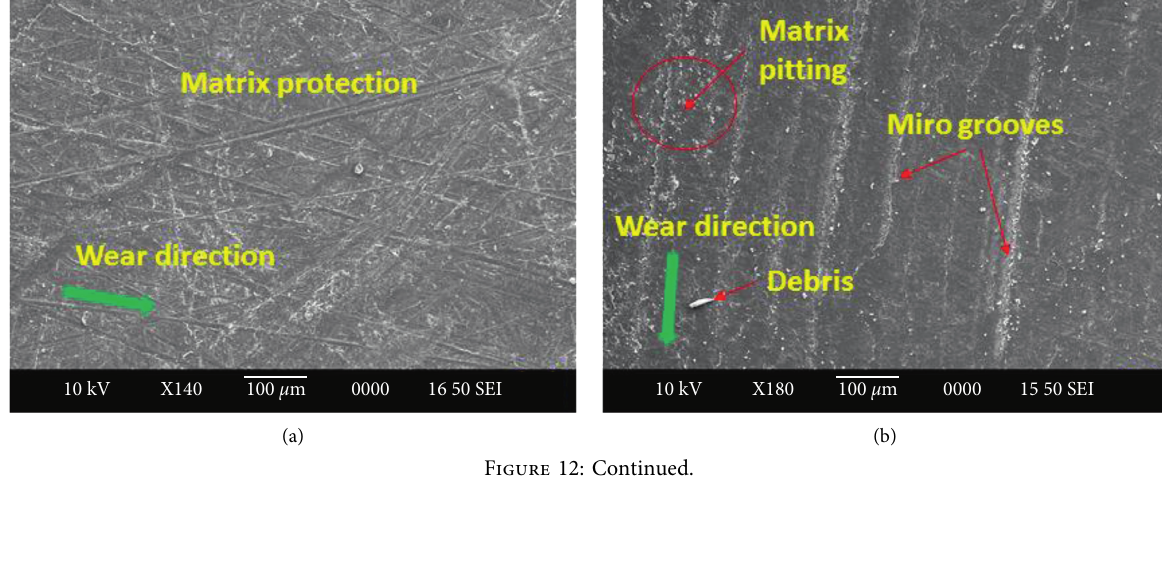
3 -treated fiber with